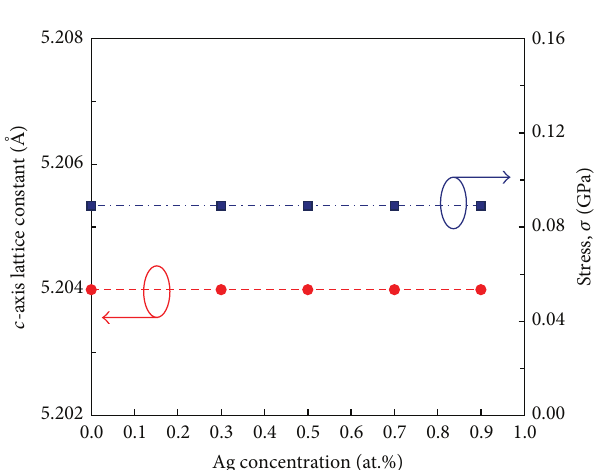
Figure 2: c -axis lattice constant and residual stress of undoped and Ag doped ZnO thin films.